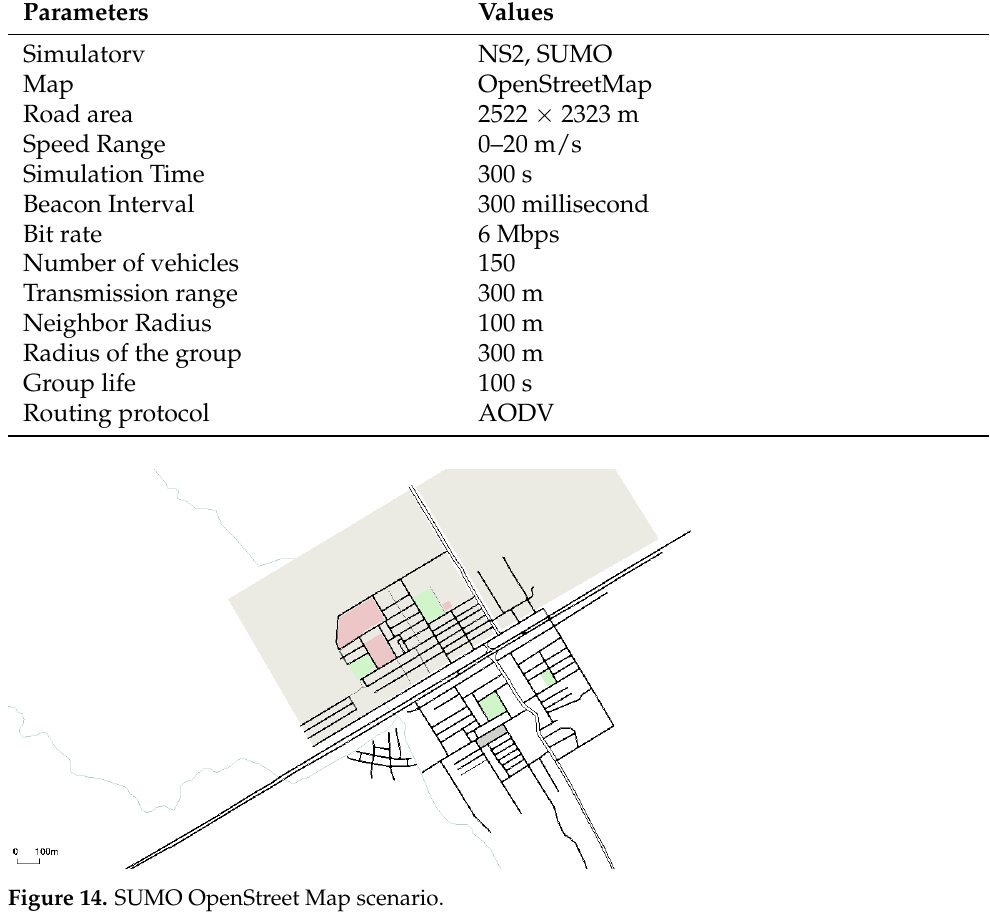
Table 8. Simulation parameters for DGVP.